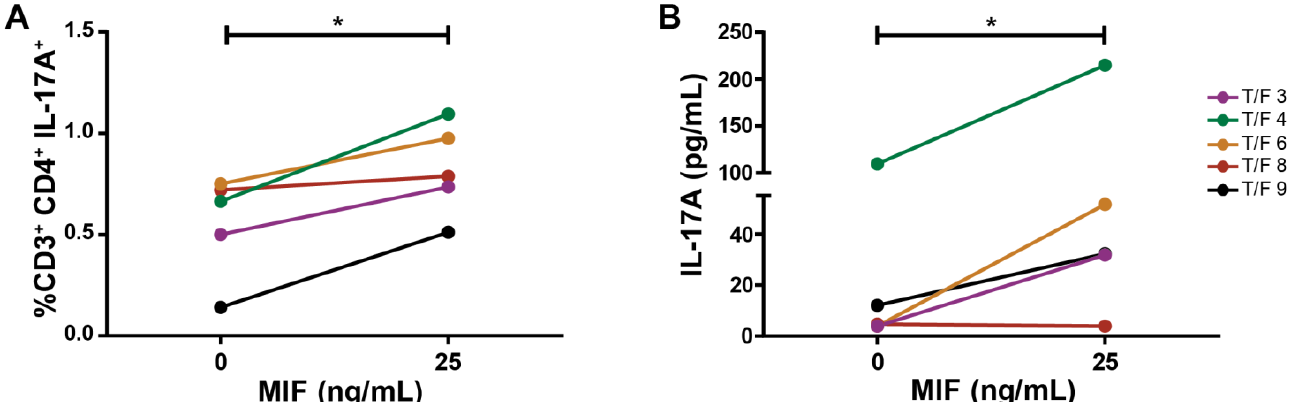
Figure 5. Transmitted/founder (T/F) HIV-strain MDM infection of co-culture resembles Th17-like profiling. ( A ) Proportion of IL-17A-expressing CD4TLs on MIF-treated co-cultures with T/F HIV-strain-infected MDMs. ( B ) Soluble IL-17A concentration in culture supernatants on MIF-treated co-cultures with T/F HIV-strain-infected MDMs. Data show the mean of two independents experiments with five different T/F HIV strains each one performed in triplicate. Data analysis was performed with a Student ’s t -test (* p < 0.05).